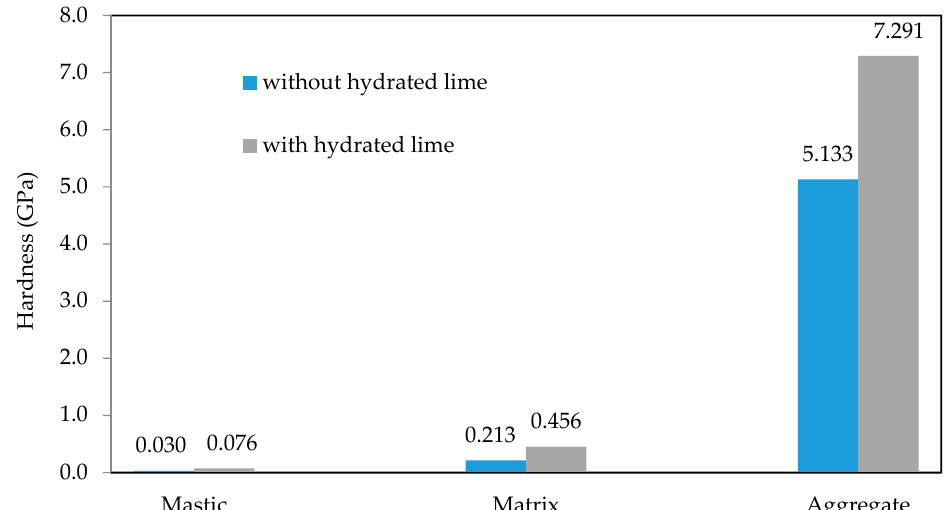
Figure 15. Average hardness values obtained from the indentation grids.